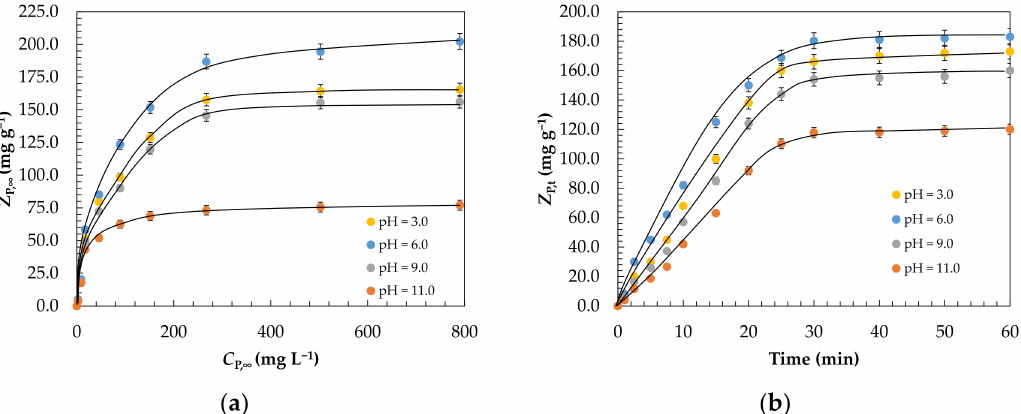
Figure 2. Determination of the adsorption parameters for the different pH values studied and at a temperature of 20 ◦ C. ( a ) Adsorption isotherms of phenol on GAC; ( b ) evolution of adsorption kinetics fitted to a pseudo-second order model for different hydraulic retention